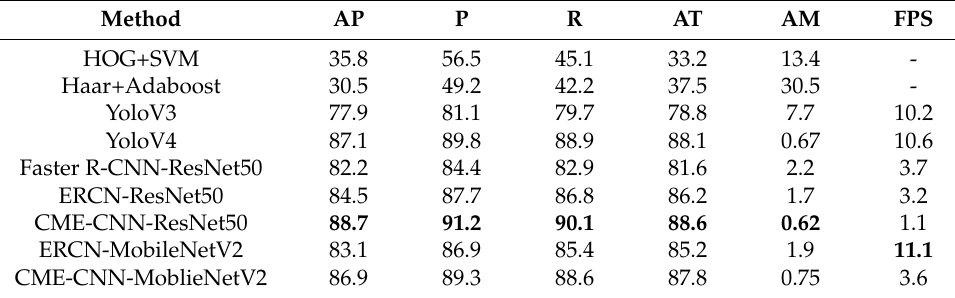
Table 4. Quantitative results of all the examined